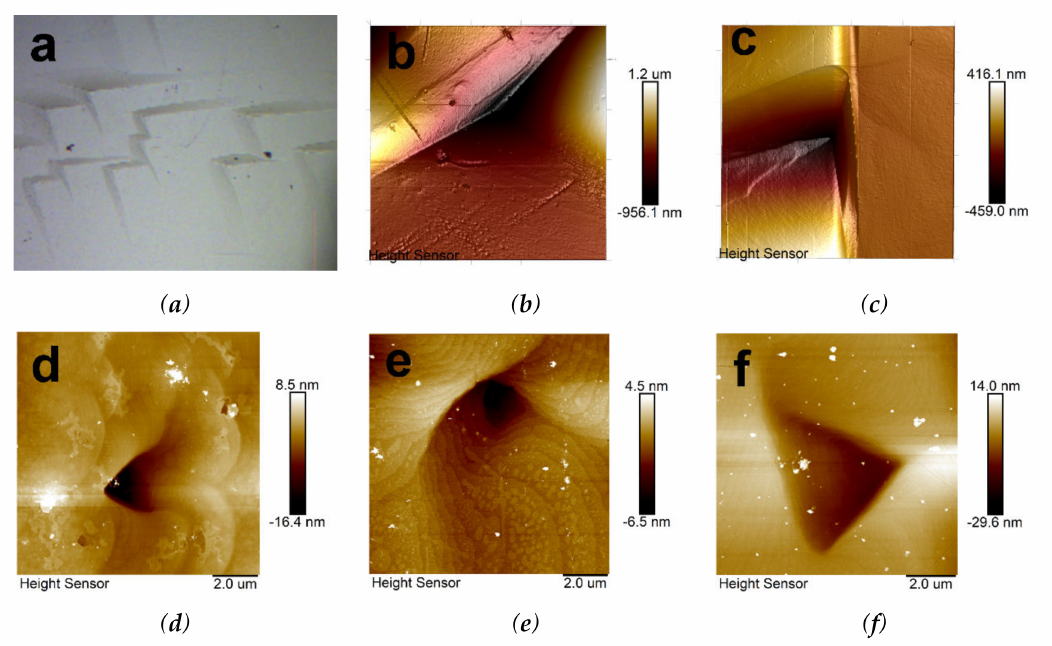
Figure 7. Microtopography of (101) faces of KDP crystals grown in [101] direction under di ff erent supersaturation: ( a ) photo of etch pit; ( b ) 3D image of etch pit; ( c ) 3D image of triangular pit; ( d ), ( e ), ( f ) morphology of triangular pit under di ff erent supersaturation.